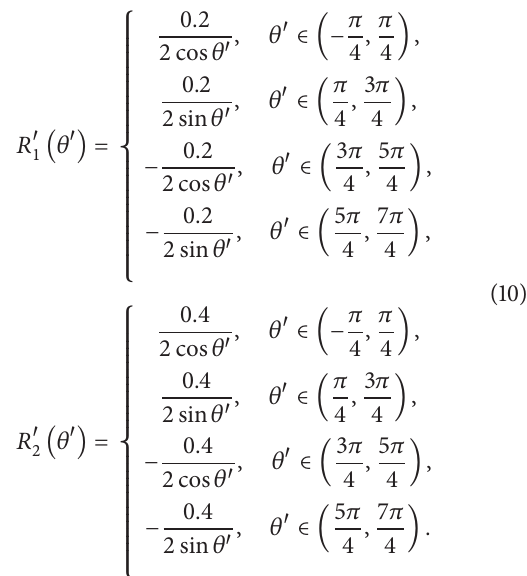
and 0.4 m, respectively. The cloak boundary functions can be expressed